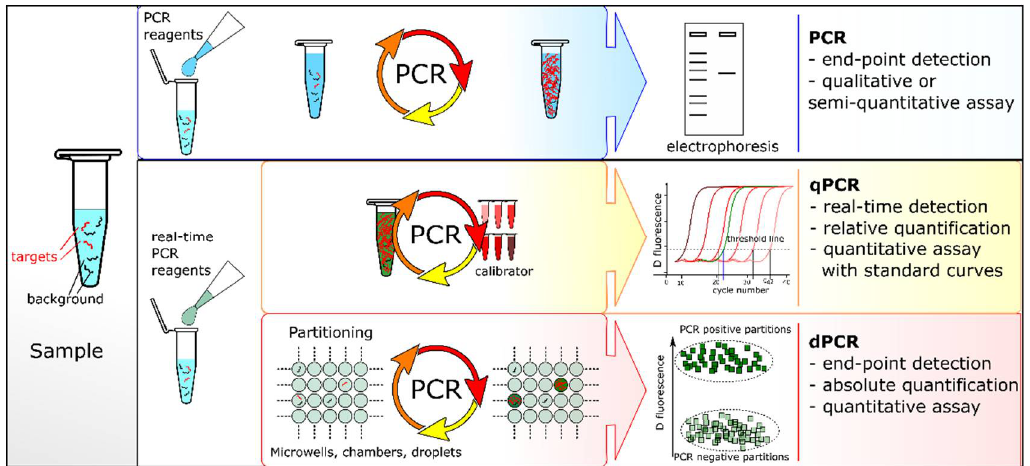
Figure 4. Comparison of PCR-based techniques. In conventional PCR, the amplification products are analyzed at the end of the reaction (end-point PCR) by gel electrophoresis and detected after fluorescent staining. qPCR and dPCR use the same amplification reagents and fluorescent labeling systems. In qPCR, the amount of amplified DNA is measured at each cycle during the PCR reaction, i.e., in real-time. The ‘absolute’ quantity of target sequence is interpolated using a standard curve generated with a calibrator. In dPCR, the sample is first partitioned into many sub-volumes (in microwells, chambers or droplets) such that each partition contains either a few or no target sequences. After PCR, the proportion of amplification-positive partitions serves to calculate the concentration of the target sequence using Poisson’s statistics.